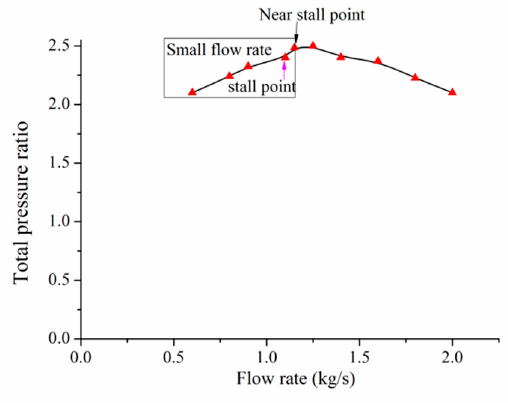
Figure 5. The compressor performance curve of the flow rate and pressure ratio.